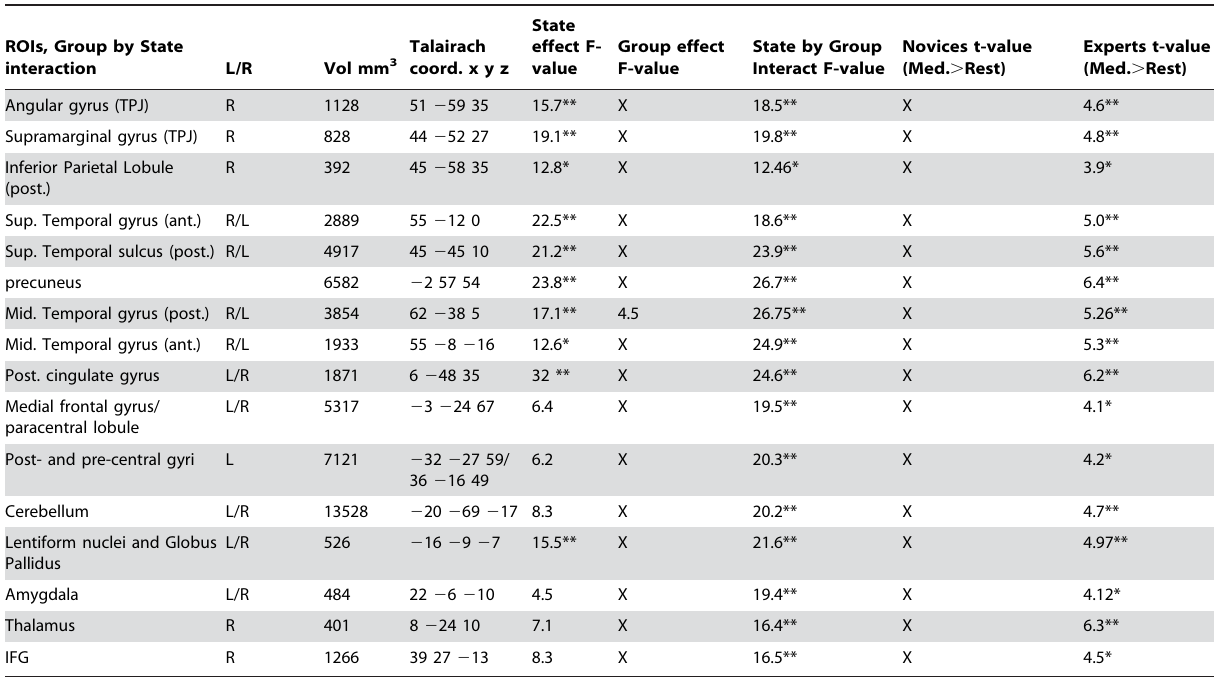
Clusters extracted from the ROIS showing State effect (p , 0. 05 corrected, repeated ANOVA). Paired t-tests comparing responses during meditation and resting states were run within each group in each of these ROIs (p , 0.05). * indicates p , 0.005, ** p , 0.0005, X indicates